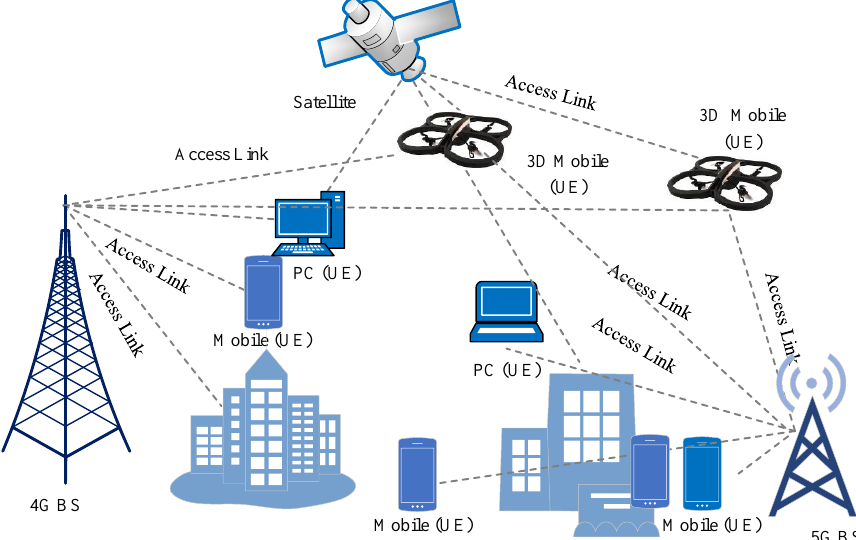
Figure 5. UAVs as normal users in a future ultra – dense heterogenous